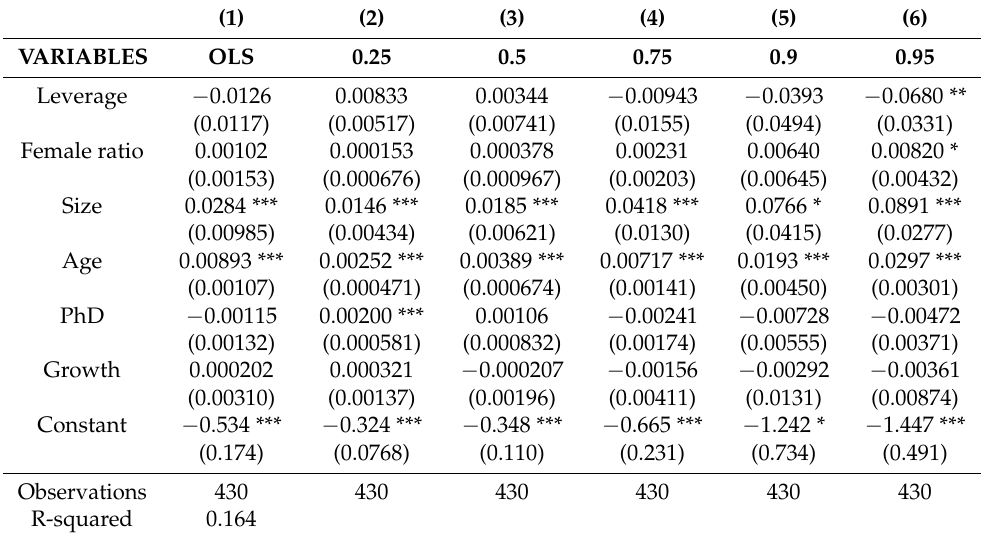
Table 10. The Quantile impact of gender diversity on EPS.